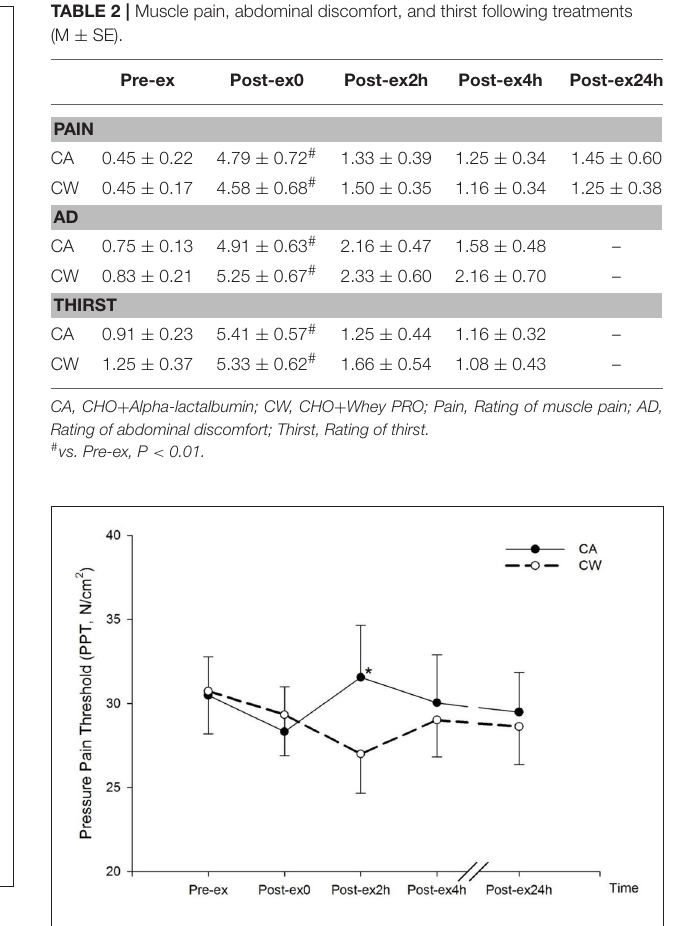
FIGURE 3 | Changes in Pressure Pain Threshold (PPT) following main trials. (*vs. CW, P < 0.01; CA, CHO + Alpha-lactalbumin; CW, CHO + Whey PRO).